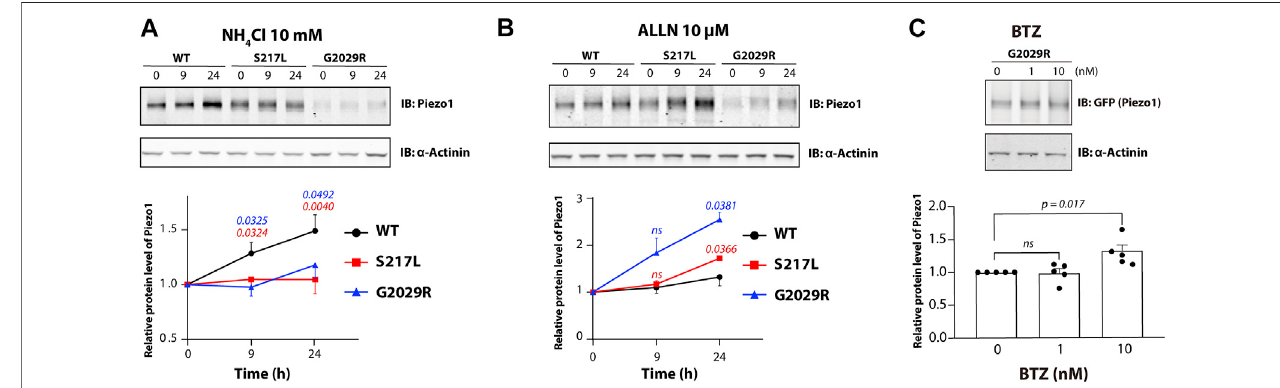
FIGURE2| S217LandG2029RPiezo1mutantsgothroughproteasomaldegradation.Piezo1 − / − HEK293TcellsoverexpressingWTormutantPiezo1weretreated with (A) a lysosomal degradation inhibitor NH 4 Cl or (B) a proteasomal degradation inhibitor ALLN for 0, 9 or 24 h. Representative results are shown in the upper panel. Lower panel, summary data of the corresponding experiments with comparison between mutant and WT Piezo1 shown in blue for G2029R and in red for S217L. (C) Piezo1 − / − HEK293T cells overexpressing G2029R Piezo1 were treated with 0, 1 or 10 nM of Bortezomib for 24 h before being collected for western blot. Upper panel, representative western blot. Lower panel, summary dataofthewesternblot experiments. OnewayANOVA with Dunnett ’ smultiplecomparison test wasused for statistical analysis (ns (cid:2) not signi fi